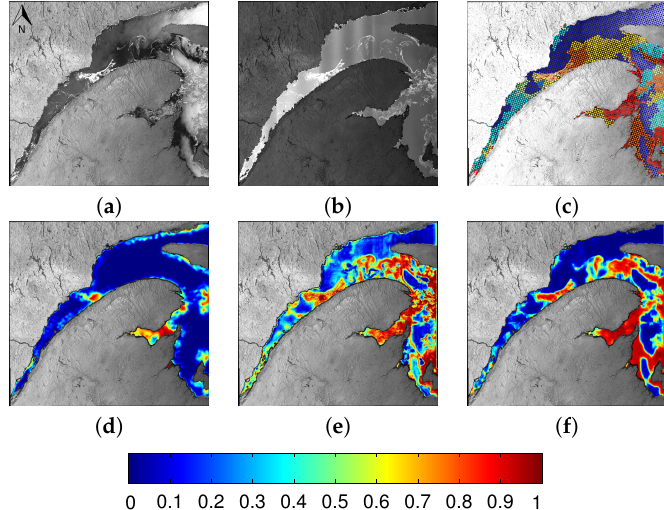
Figure 4. Ice concentration estimated by CNN compared to that from other methods. The HH and HV images are shown in panels ( a ) and ( b ) repectively. Panel ( c ) is the image analysis, ( d – f ) are the ice concentration from ASI, MLP40 and CNN, repectively. Scene shown is 20140117_103914, which is used for testing. Scene centered at 47.99 ◦ N, 66.85 ◦ W with extent of 500 km by 500